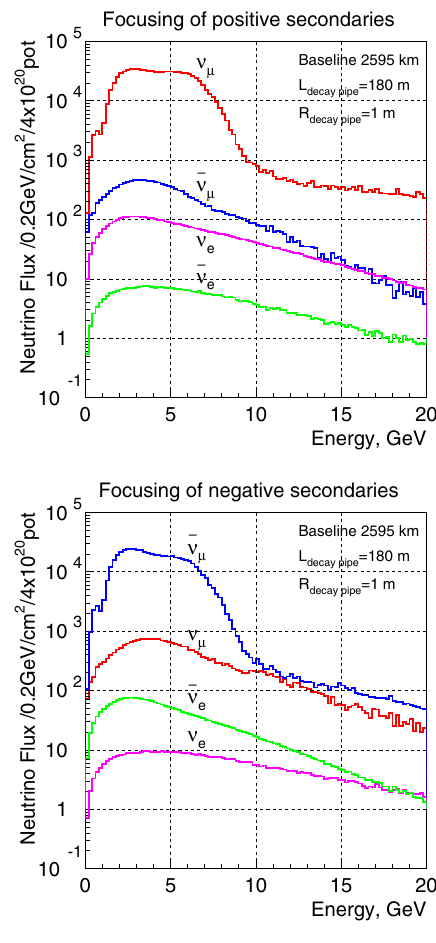
Fig. 5 Simulated spectra of the P2O neutrino beam at the ORCA loca- tion in neutrino (top panel) and antineutrino (bottom panel) mode. The absolute normalisation is given for 4 × 10 20 protons on target (POT), which corresponds to 1 year of operation at the beam power of 450 kW, or 5 years with 90